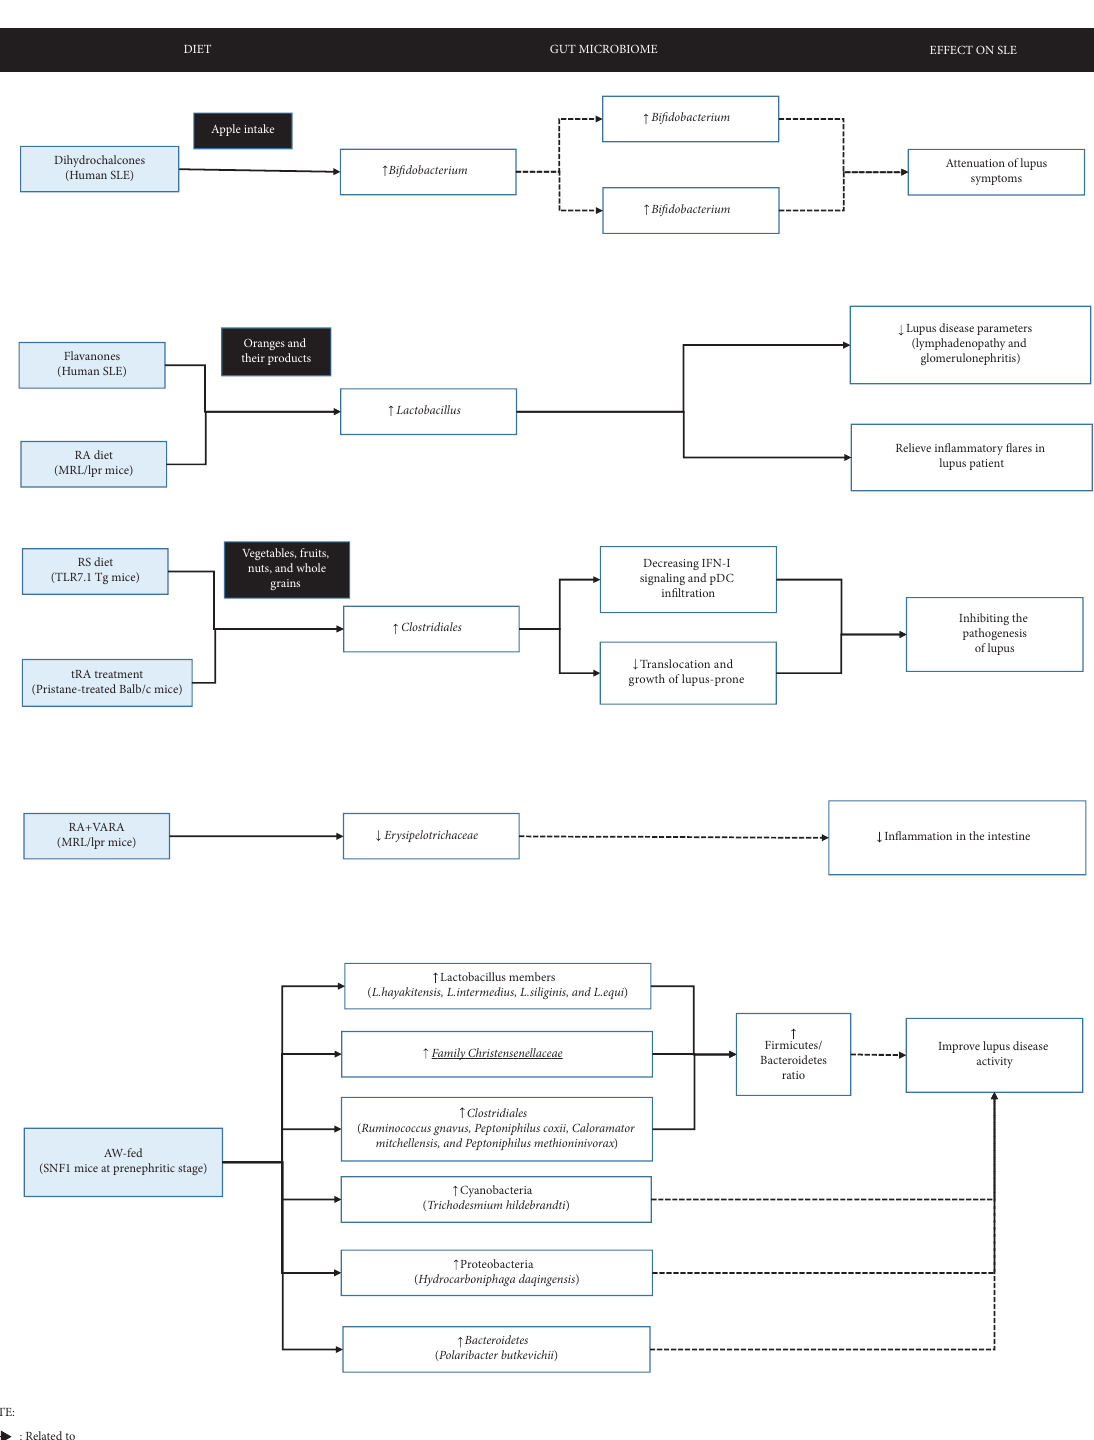
Figure 2: Emerging evidence points to a potential link between diet, gut microbiome, and benefcial efect to